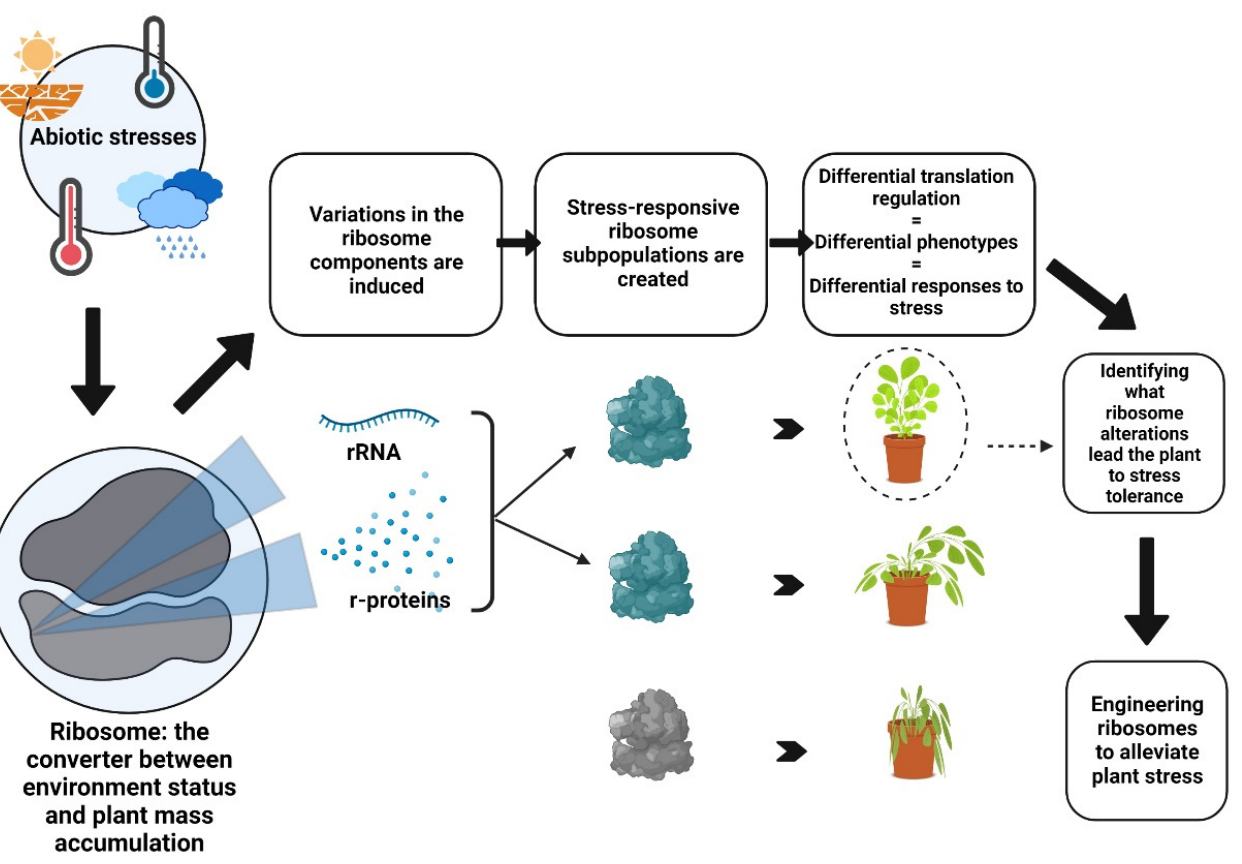
Figure 1. The crosstalk between ribosome heterogeneity and abiotic stress response in plants (Figure created with BioRender.com, accessed on 25 July 2022).